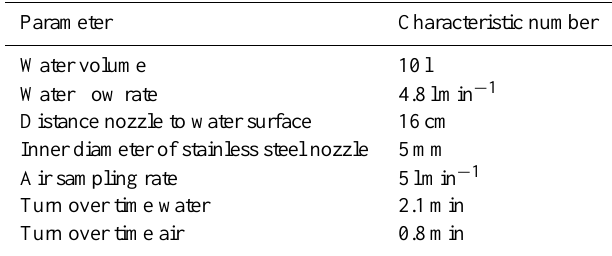
Table 2. Physical characteristics of the bubble